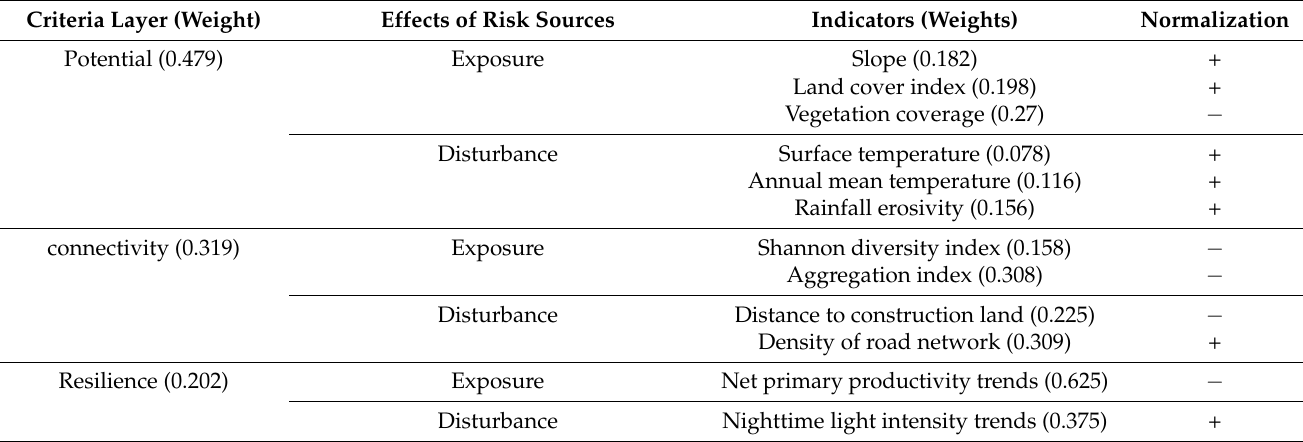
Table 3. Landscape ecological risk assessment index system. Criteria Layer (Weight) Effects of Risk